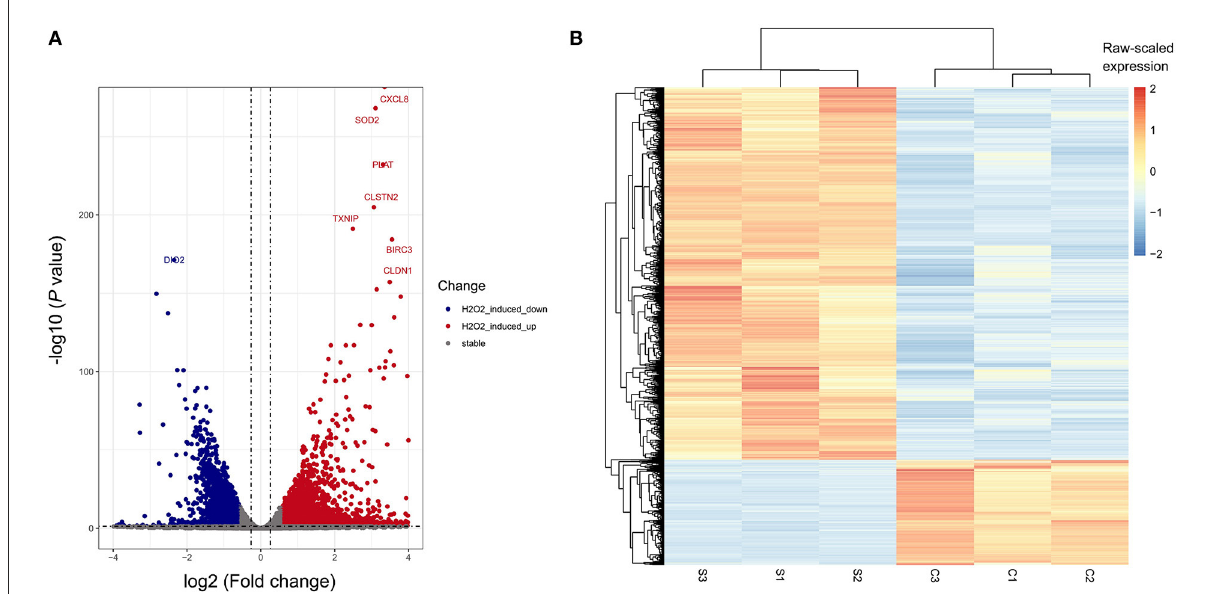
FIGURE2 Differentially-expressed genes (DEGs) of H 2 O 2 -treated ARPE-19 cells. (A) Volcano plot of DEGs of RPE cells induced by H 2 O 2 . (B) Heatmap plot of DEGs of RPE cells induced by H 2 O 2 . S, H 2 O 2 group; C, Ctrl